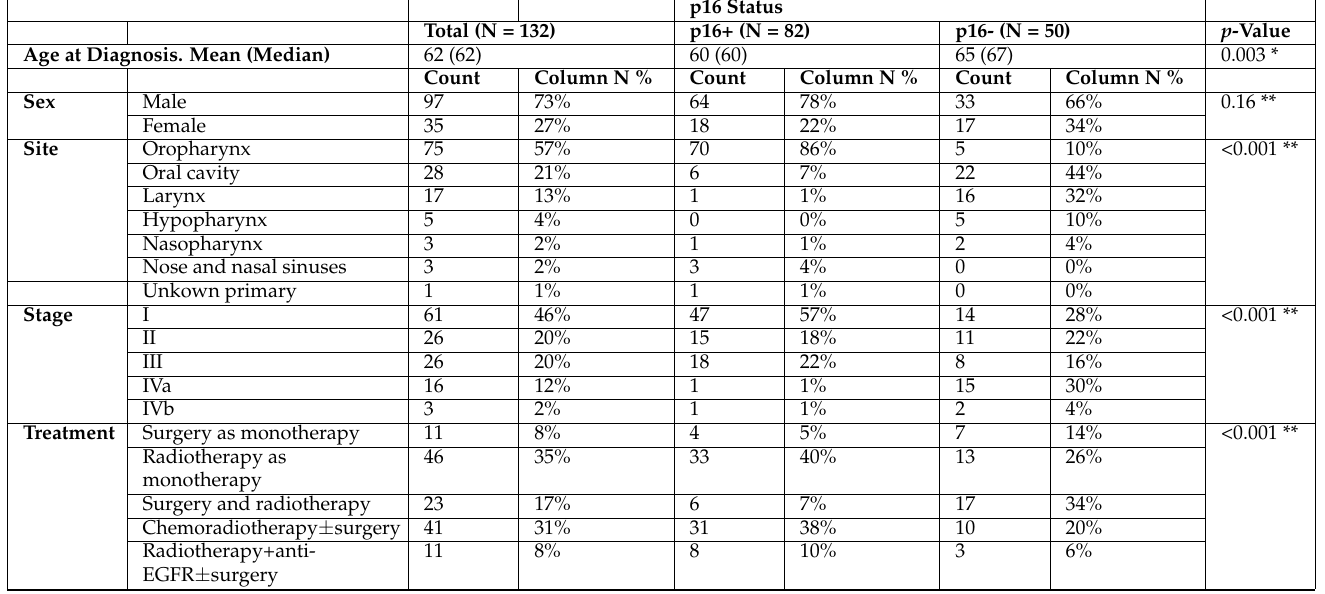
Table 1. Characteristics of a cohort consisting of 132 patients with head and neck cancer. p -values for sex, site, stage, and treatment were calculated using Fischer’s exact test. For age, the Wilcoxon rank-sum test was used. (* Fischer’s exact test, ** Wilcoxon rank-sum test). p16 Status Total (N = 132) p16+ (N = 82) p16- (N =